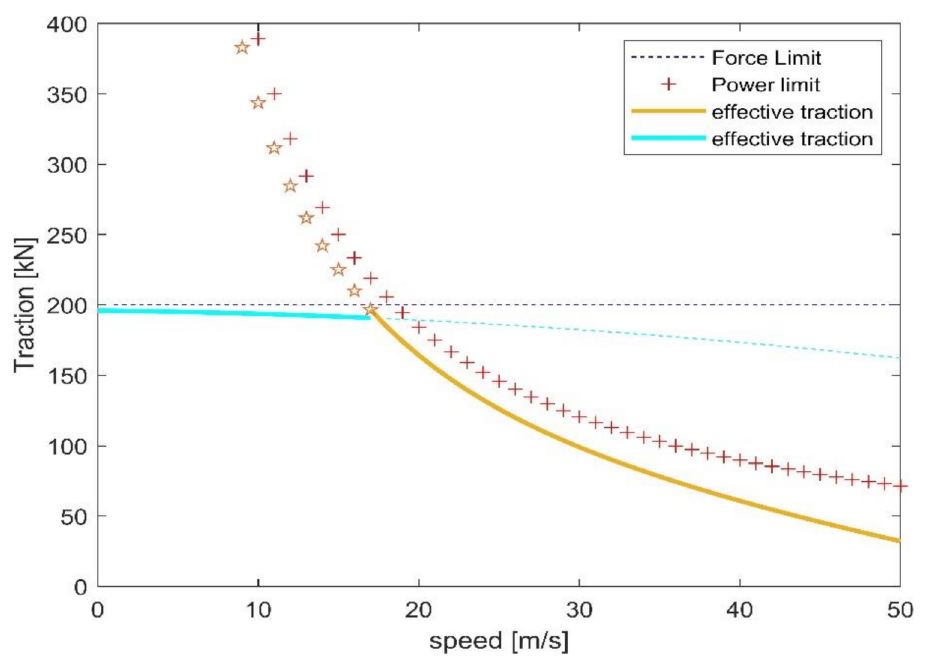
Figure 2. Tractive effort of the